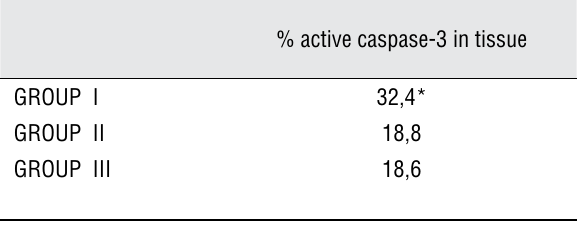
Table 1 – Quantitative analysis of active caspase-3 in tissue.